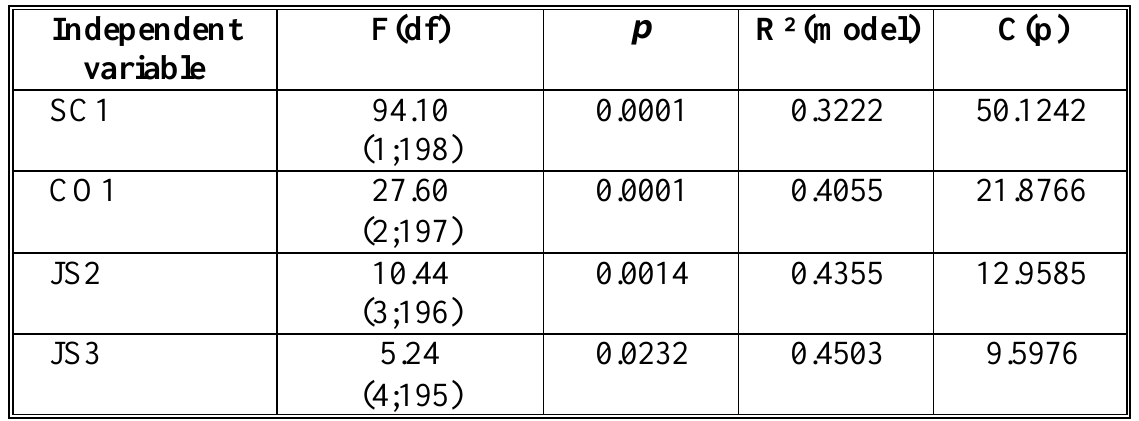
Dependent variable: Entrepreneurial attitude 1: Innovation